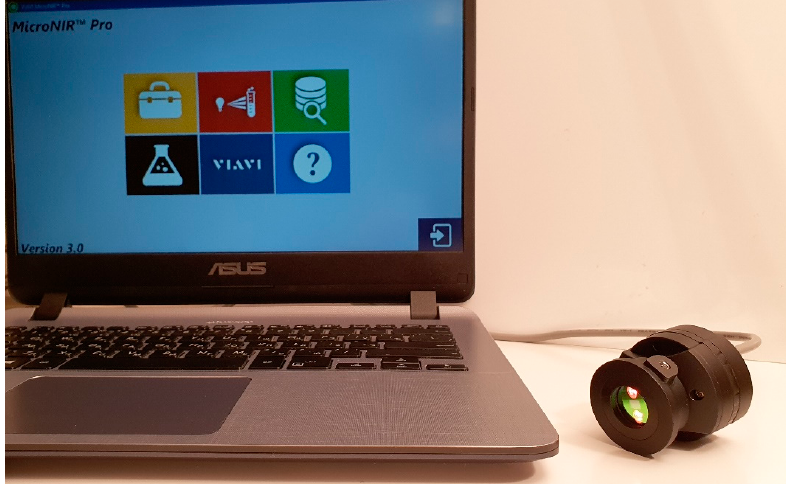
Figure 1. Ultra-compact near infrared (NIR) spectrometer MicroNIR 1700ES.